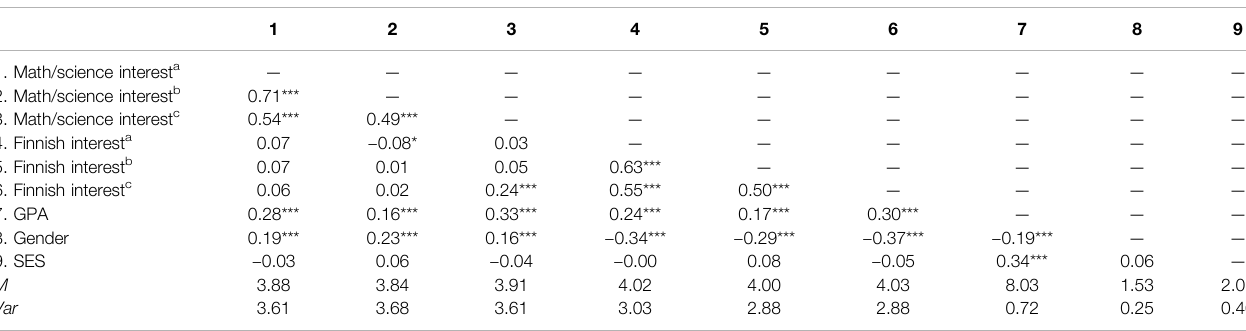
TABLE 5 | Correlations, means, and variances for the Finnish sample.